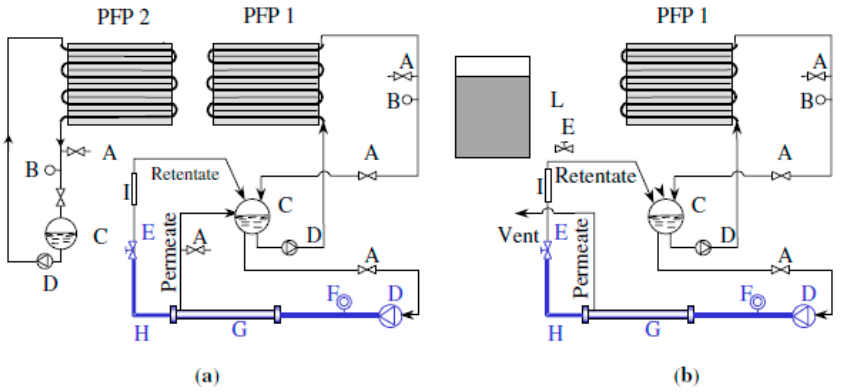
Figure 7. Scheme of the photoreacting batch systems ( a ) and of the photoreacting continuous system ( b ): (A) switch valve; (B) thermocouple; (C) non-reacting tank; (D) pump; (E) regulation valve; (F) manometer; (G) membrane vessel; (H) line under pressure; (I) rotameter; (L) feed tank; (PFP) plug flow photoreactor. Reproduced with permission from [47], Copyright Elsevier Ltd., 2005.